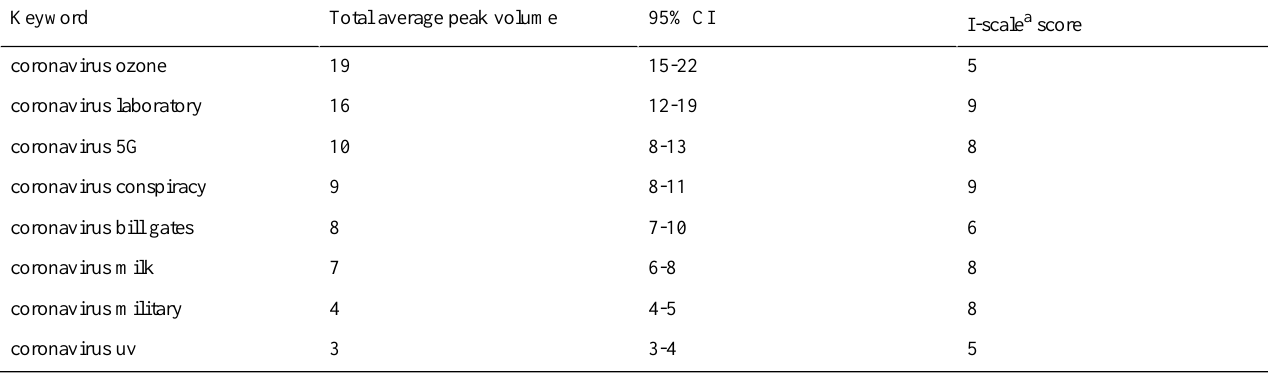
Table 2. Top global fake news–related Google searches on coronavirus disease